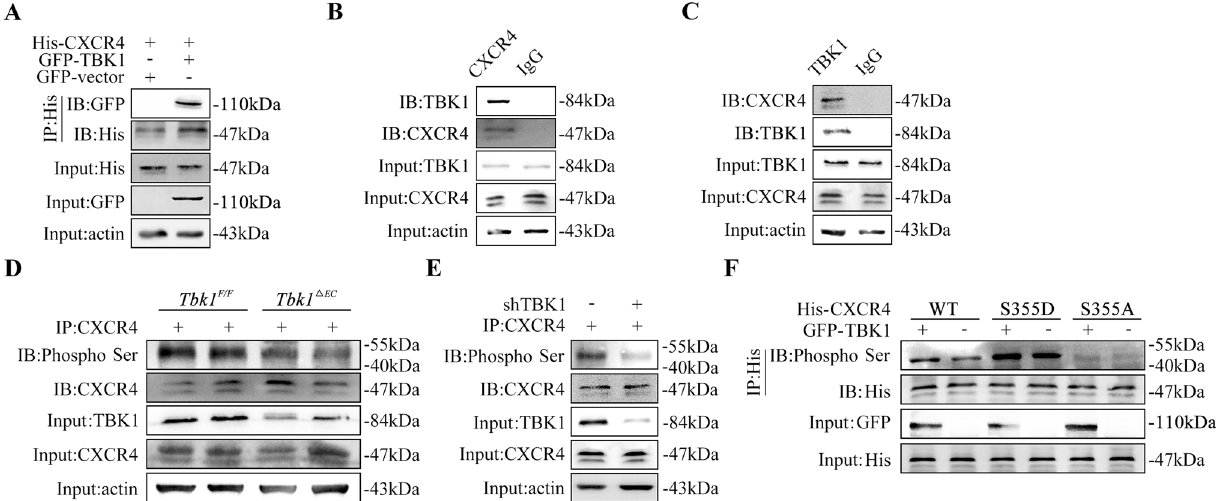
Fig. 5 CXCR4 is phosphorylated by TBK1 at serine residues 355. A Coimmunoprecipitation (Co-IP) results showing the interaction of GFP- TBK1 with His-CXCR4 in HEK293T cells. Three independent experiments were performed. B Endogenous TBK1 was immunoprecipitated with CXCR4 in bEnd.3 cells. Three independent experiments were performed. C Endogenous CXCR4 was immunoprecipitated with TBK1 in bEnd.3 cells. Three independent experiments were performed. D CXCR4-serine phosphorylation level was decreased in Tbk1 Δ EC retinas, which was detected by immunoprecipitation (IP). Four independent experiments were performed. E IP assay showed a decrease in CXCR4-serine phosphorylation level in bEnd.3 cells transfected with shTBK1. Three independent experiments were performed. F The effect of CXCR4 Ser355 mutation on CXCR4-serine phosphorylation level in response to TBK1 overexpression in HEK293T cells. Three independent experiments were performed. actin: β